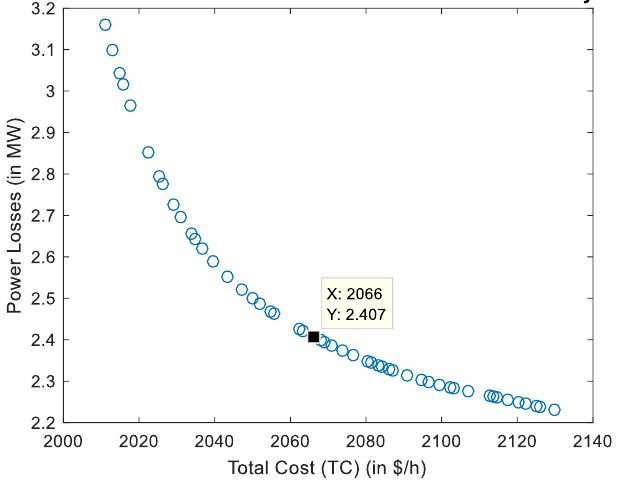
Figure 4. POF and trade-off solution for total cost and power loss minimizations of unbalanced 17 bus